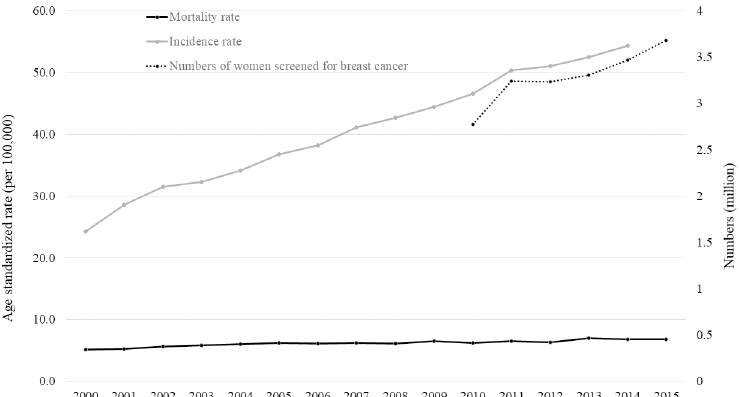
Fig 1. Age-standardized breast cancer incidence and mortality rate, and the number of women screened for breast cancer in South Korea from 2000–2015.